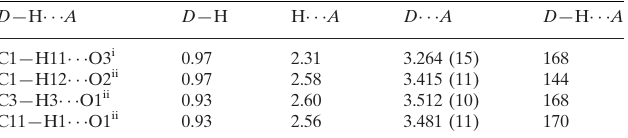
Hydrogen-bond geometry (A˚ , (cid:4)